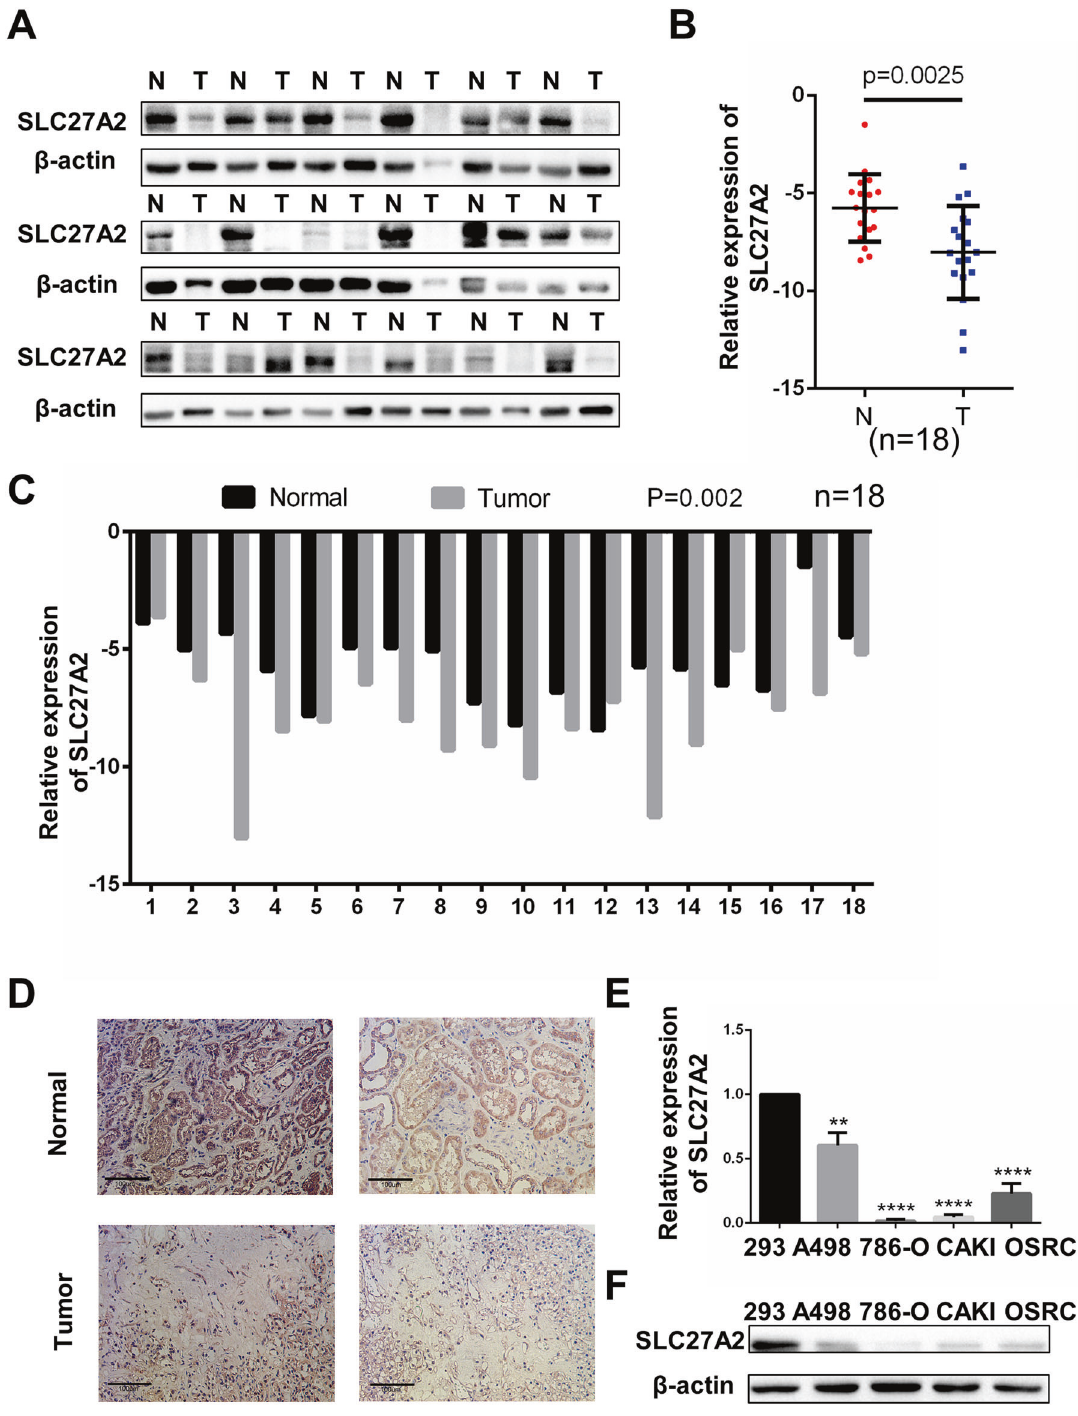
Fig. 3 SLC27A2 was signi fi cantly downregulated in ccRCC tissues and cell lines. A The protein levels of SLC27A2 in ccRCC tissues and neighboring normal tissues. B , C qRT-PCR analysis of SLC27A2 mRNA expression in 18 pairs of ccRCC tissues and neighboring normal tissues. D The immunohistochemistry (IHC) staining for SLC27A2 in ccRCC tissues and neighboring normal tissues (Magni fi cation: 200×). E , F The mRNA levels and protein levels in fi ve ccRCC cell lines (A498, 786-O, CAKI, and OSRC) and normal cell line (293), t -test, ** p < 0.01,**** p <